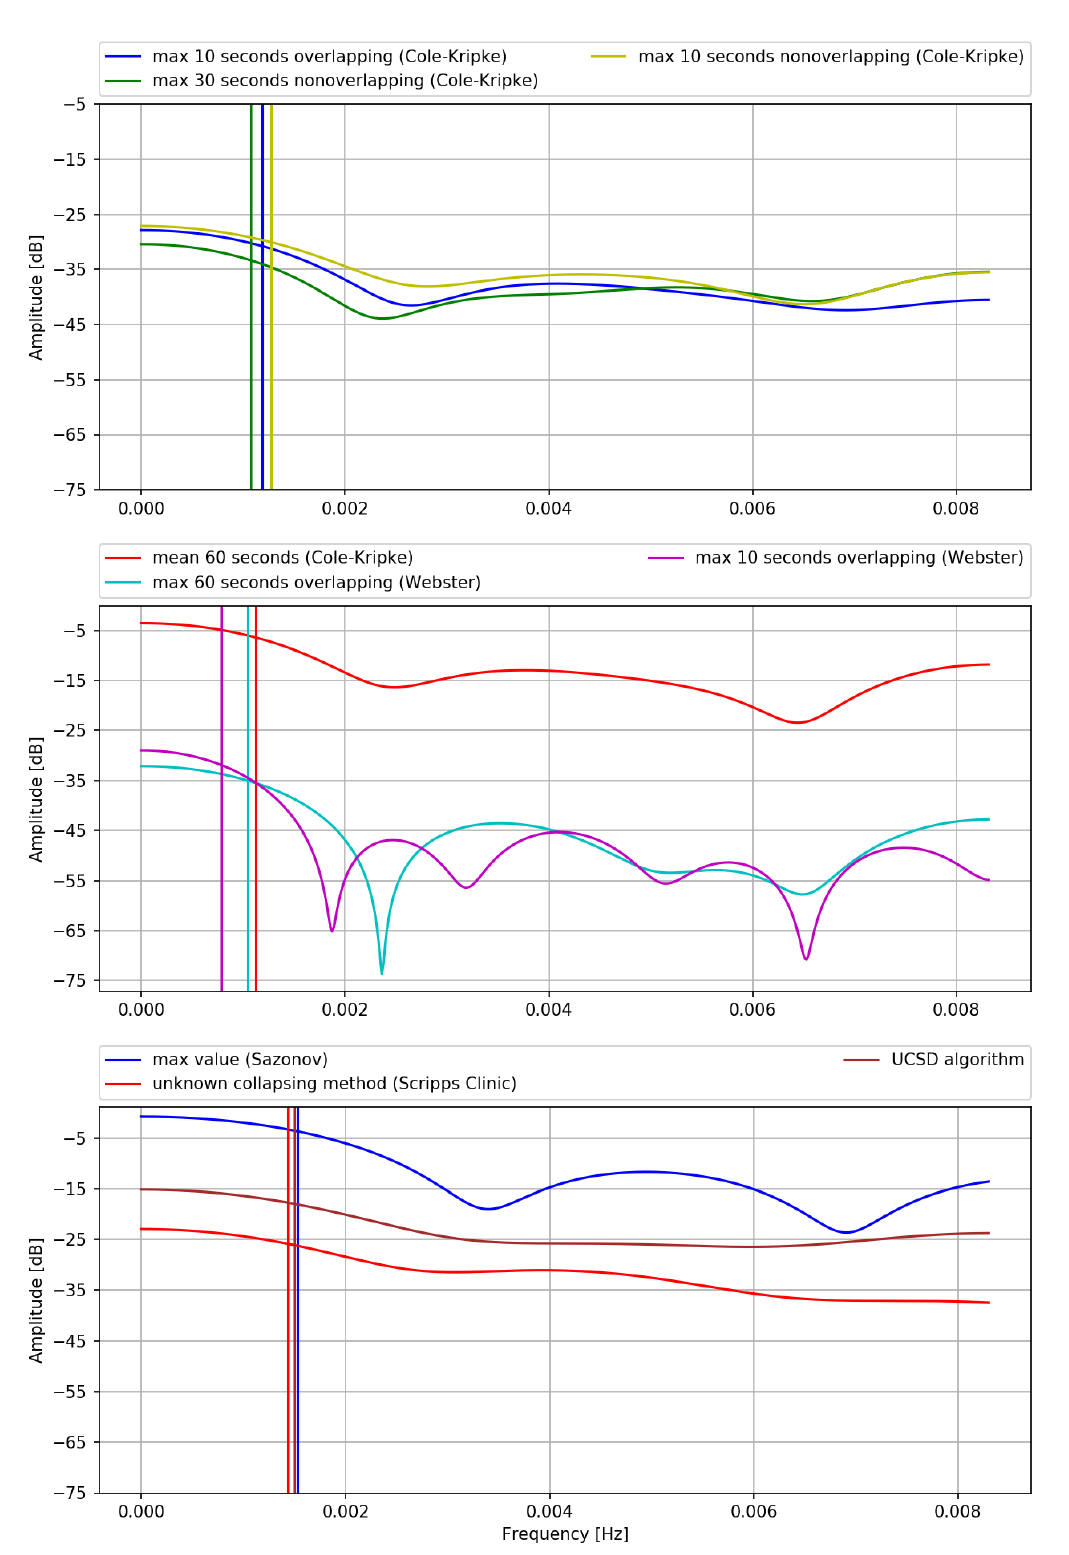
Figure 1. Transmittances of the FIR filters representing step (2.) of the Cole-Kripke algorithm family, aderived from the coefficients published by Authors. Vertical lines mark corresponding cutoff